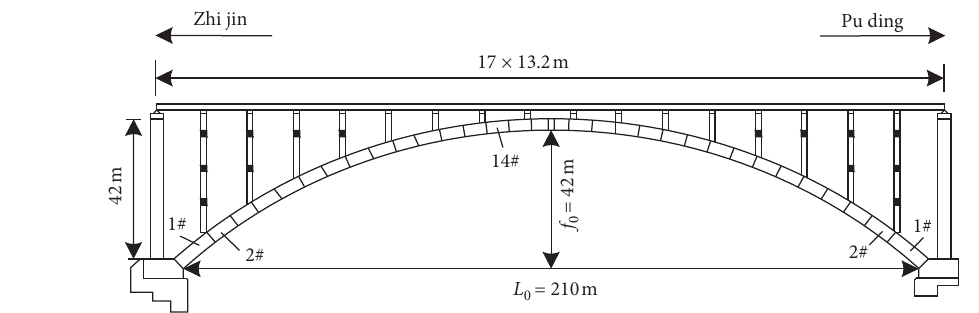
Figure 6: The general layout of the bridge (units: (m).